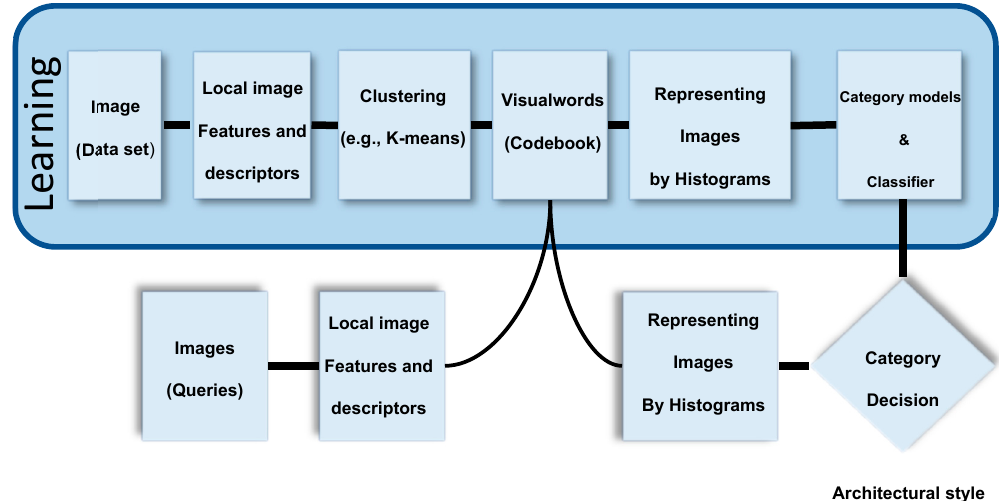
Figure 6. Learning visual words and classification (our own redrawing) scheme [36].